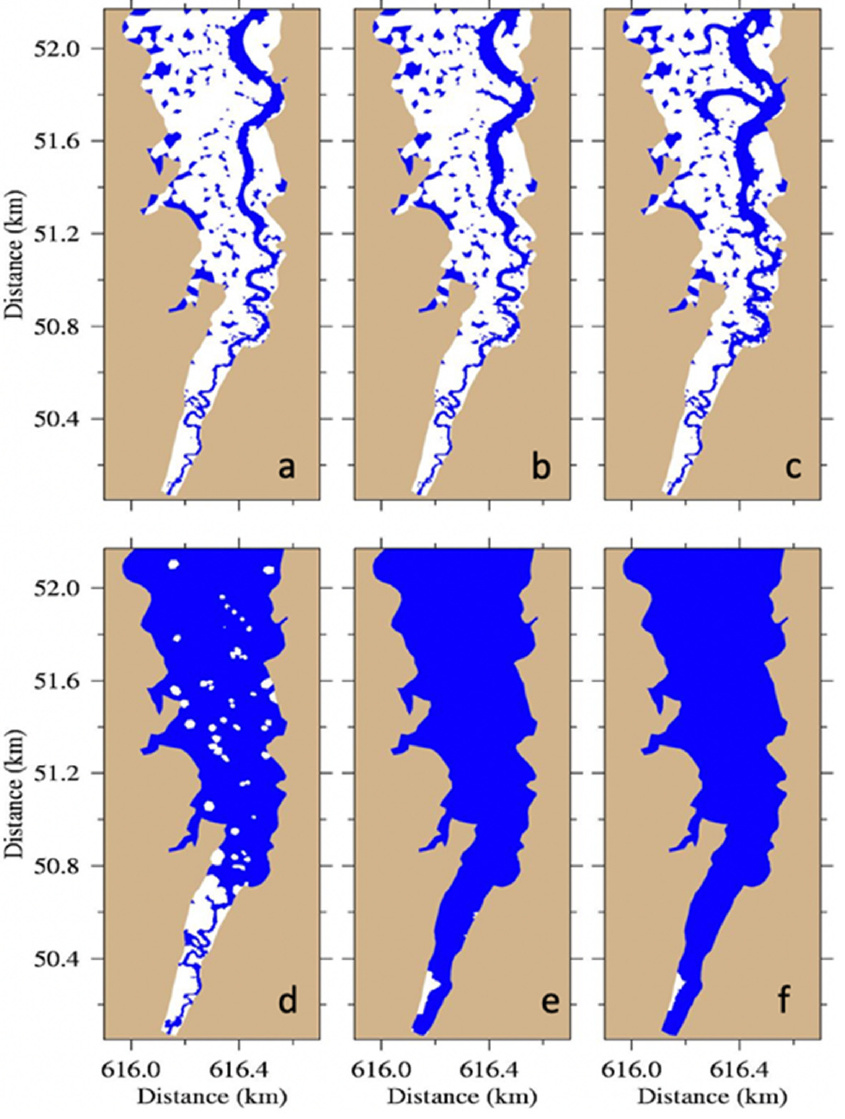
Figure 13. Simulated flooded areas at 9:38 AM ( a ), the lowest water level, 10:13 AM ( b ), 11:12 AM ( c ), 13:04 PM ( d ), 14:08 PM ( e ), and 15:04 ( f ), the highest water level, 9 November 2001, in the Okatee tidal creek.